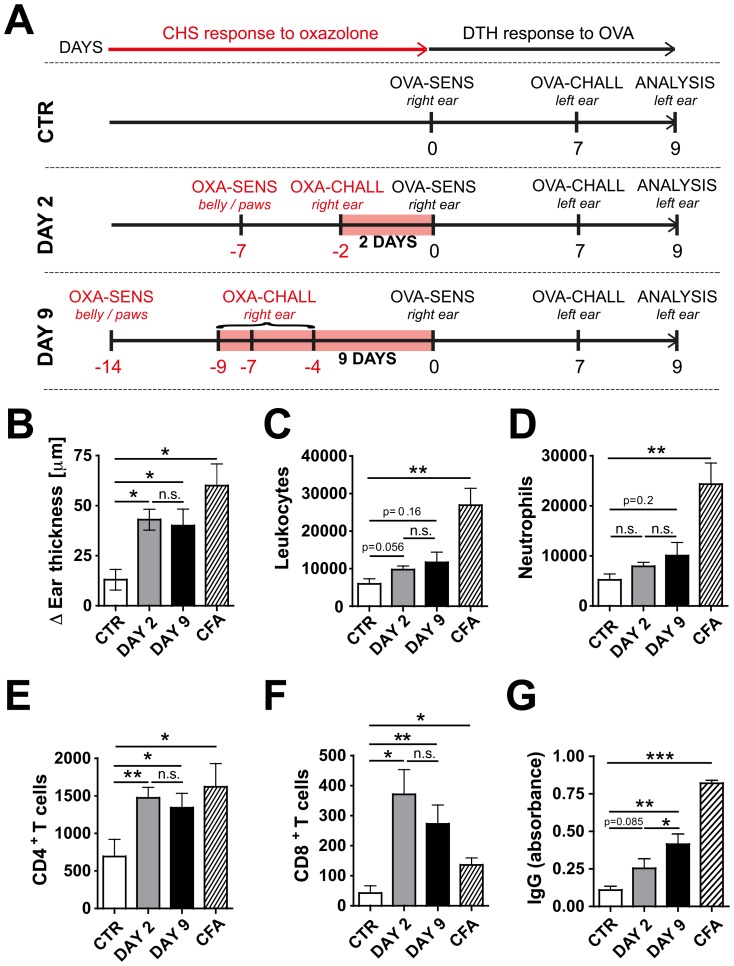
Skin inflammation enhances the induction of a DTH response to OVA in WT mice.(A) Schematic representation of the experiment: WT mice were grouped into a control (CTR) group, a DAY 2 and a DAY 9 group. On day -14 and day -7, mice from the DAY 9 group or the DAY 2 group, respectively, were sensitized by application of oxazolone (OXA) onto the belly and paws (indicated as OXA-SENS). 5 days later (day -9 or day -2) a CHS response was induced, by challenging mice from the DAY 9 or DAY 2 groups with oxazolone on the right ear (indicated as OXA-CHALL). In mice belonging to the DAY 9 group, OXA was repeatedly applied onto the right ear on day -7 and day -4, to maintain the inflammatory response. On day 0, corresponding to 2 days (DAY 2 group) and 9 days (DAY 9 group) after the onset of inflammation (marked as a red bar), a DTH experiment was initiated in mice from all treatment groups. To this end, all mice were immunized by OVA injection into the CHS-inflamed or control right ear (indicated as OVA-SENS). On day 7, a DTH response to OVA was induced by OVA injection into the left ear (indicated as OVA-CHALL). The strength of the immune response in the left ear was analyzed two days later (day 9). (B) The ear swelling response in the left ear was significantly stronger when mice had been immunized by OVA injection into the inflamed, right ear. The Δ ear thickness is shown, defined as the difference between the ear thickness measured at baseline and the ear thickness measured two days after DTH induction. CFA group: As a positive control group, some untreated mice were immunized by injection of OVA plus CFA into the uninflamed right ear (R) on day 0, followed by a regular OVA challenge into the left ear (L) on day 7 (as described in 3B). (C–F) FACS analysis was performed on single-cell suspensions of the DTH-challenged, left ear to quantify leukocyte infiltration. Quantification of (C) total leukocytes (CD45+), (D) neutrophils (CD11b+Gr1+), (E) CD4+CD3+CD45+ T cells and (F) CD8+CD3+CD45+ T cells. (G) Quantification of OVA-specific total IgG in the serum of mice. Representative data from 1 out of 3 similar experiments (n = 6–7 mice/group) are shown. *p<0.05; **p<0.01.